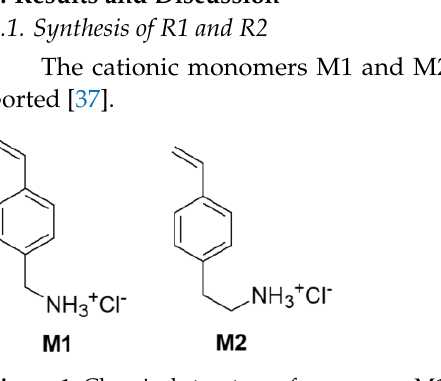
Figure 1. Chemical structure of monomers M1 and M2.